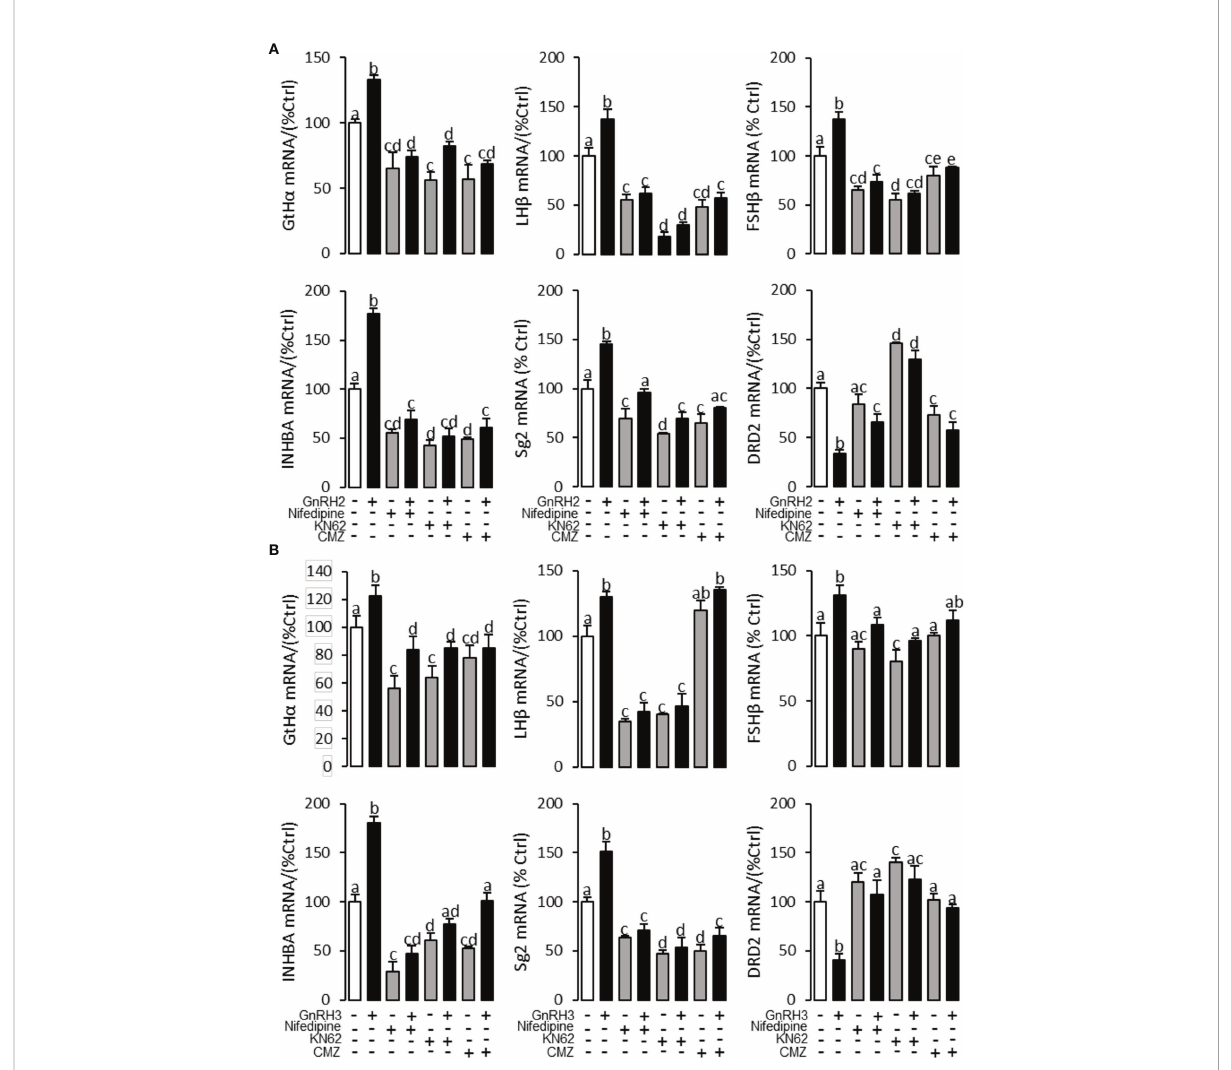
FIGURE 8 Signal transduction for GnRRH2- and GnRH3-induced GtH a , LH b , FSH b , INHBa, SgII, and DRD2 mRNA expression in grass carp pituitary cells. In this experiment, GnRH2 (A) or GnRH3 (B) combined with / without the VSCC inhibitor nifedipine (10 m M), CaM antagonist calmidazolium (1 m M), or CaMK-II blocker KN62 (5 m M) was used to incubate the grass carp pituitary cells for 24 (h) After drug treatment, the total RNA was extracted from the cells for real-time PCR of the respective genes. Data presented are expressed as mean ± SEM, and the different letters represent a signi fi cant difference at p < 0.05 between groups (ANOVA followed by a Dunnett